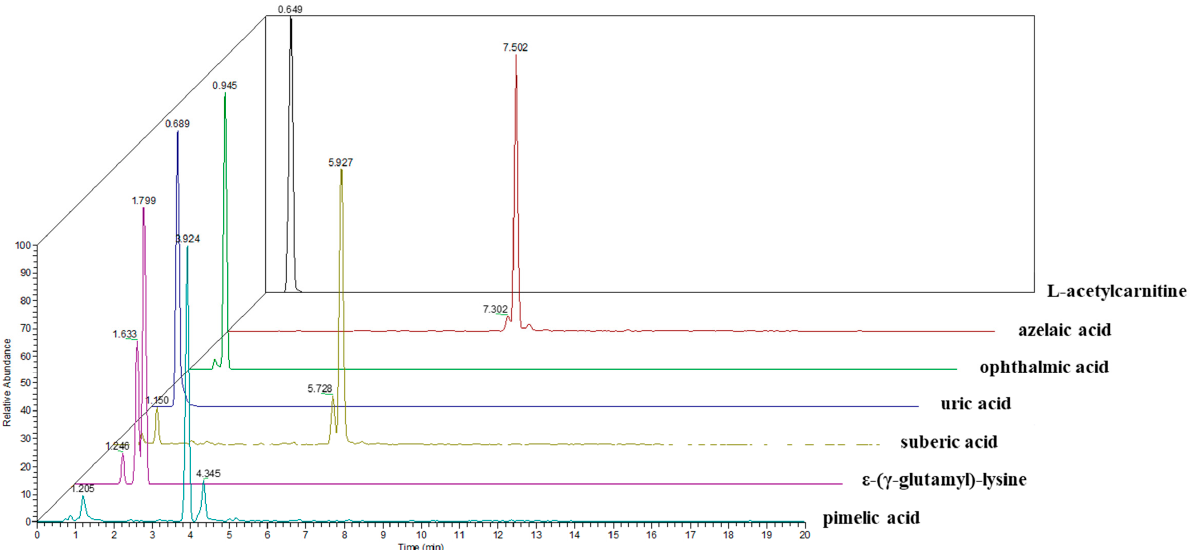
Figure 3. The extracted ion chromatogram (EIC) of a urine sample in full MS scan mode. Seven candidates were separated by difference colors. Black, L -acetylcarnitine; red, azelaic acid; green, ophthalmic acid; blue, uric acid; olive, suberic acid; purple, ε -( γ -glutamyl)-lysine; pale blue, pimelic acid.